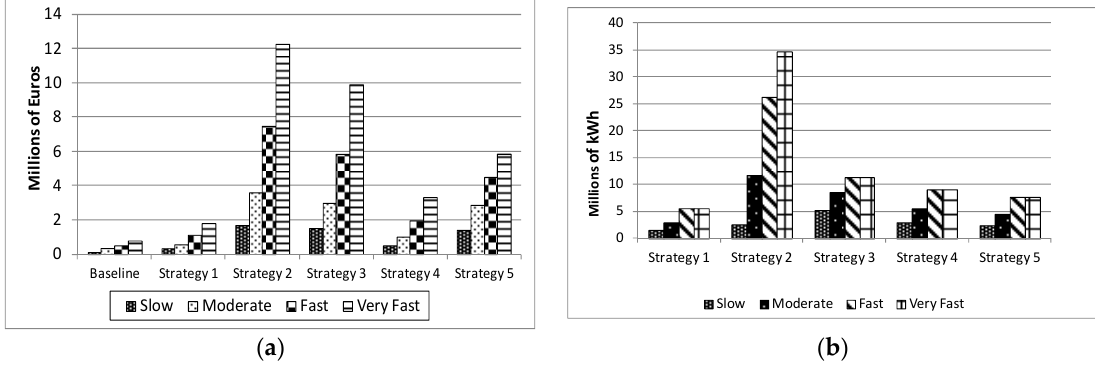
Figure 7. ( a ) Total costs for year 30 and ( b ) Total energy use for year 30 for various intervention strategies and growth scenarios in Puerto Ayora.